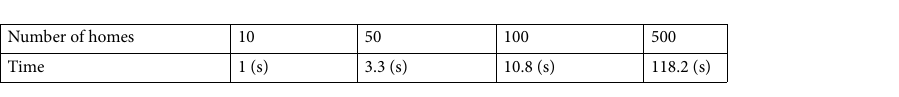
Table 4. Computational time of community with proposed